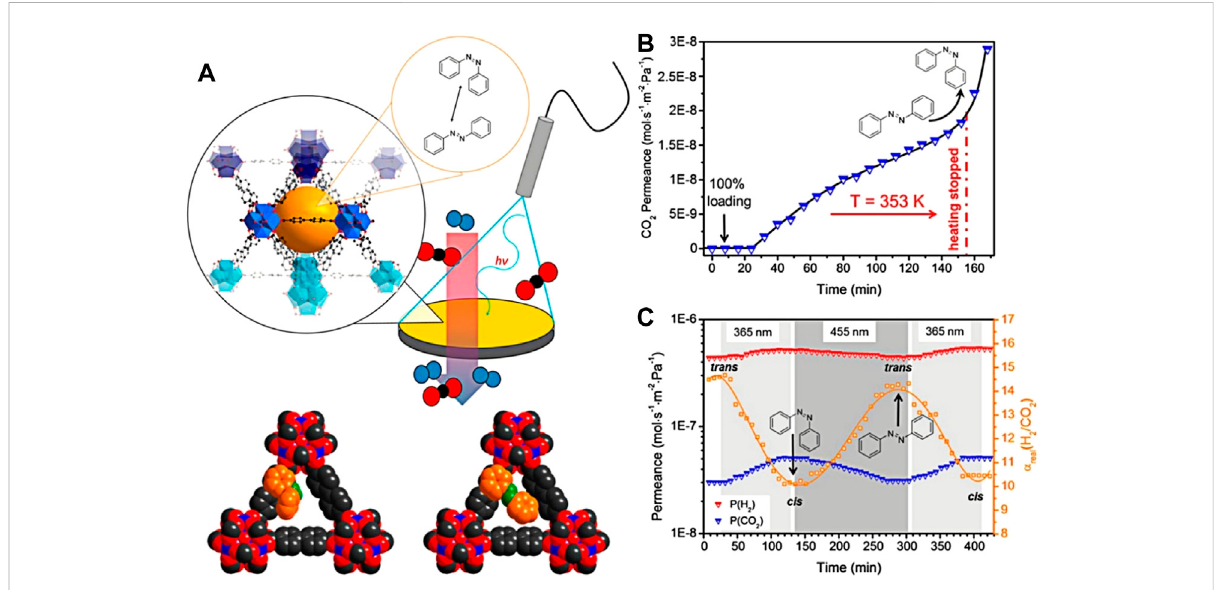
FIGURE 10 (A) StructuralchangesofAzointhecavityofUiO-67underdifferentlightconditions,andtheschematicdiagramofitsin fl uenceonthetransport of gas molecules. The gating mechanism is described by the fi lling space model. On the left is the aperture window of cis conformation, and on the right is the trans-conformation of UiO-67 and AZB; (B) controlled thermal desorption of Azo from the supporting UiO-67 layer. This desorption of Azo(fromthemembranefullyloadedwithAzo)isindirectlytracedtoanincreaseinthepermeabilityofCO 2 .During insitu desorptionprocessof Azo, the surface of the Azo@UiO-67 fi lm is irradiated by LED at 365 nm continuously, thus transforming Azo from trans - to cis -isomer. When Azo is desorbed to a certain extent, CO 2 conduction increases rapidly after heating is stopped; (C) reversible gas permeation of the H 2 /CO 2 mixture during insitu reversibleswitchingofUiO-67underconstantandreducedAzoloads.Themixedgasseparationfactor α (H et al., 2017) Copyright @ 2017